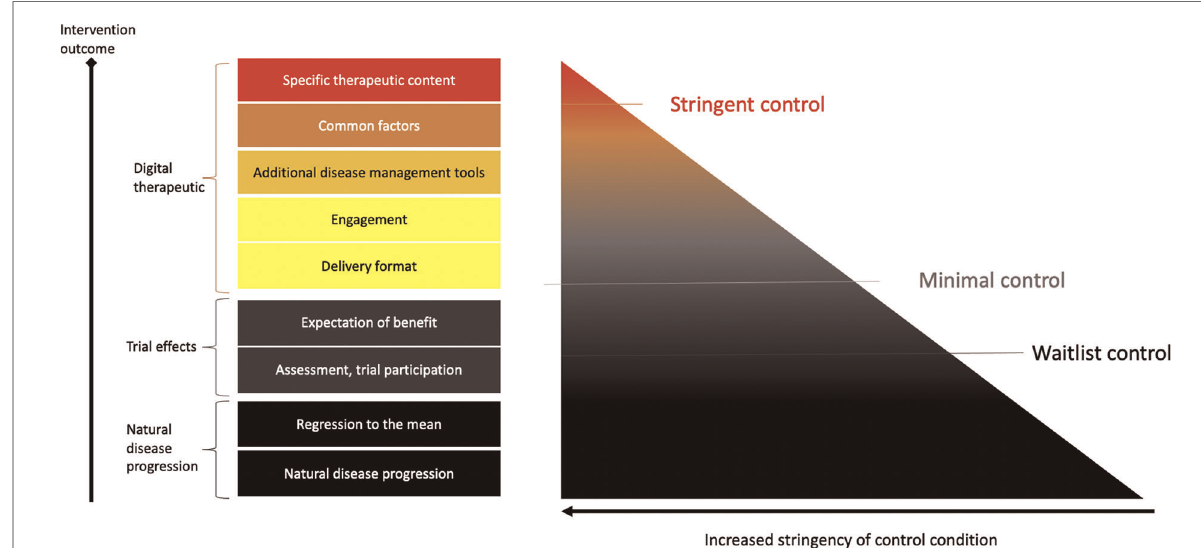
FIGURE 1 Control conditions. Control condition stringency can be distinguished with regards to what aspects are controlled for. For example, waitlist control conditions will control for aspects of natural disease progression and being regularly assessed in a trial. More stringent sham or placebo controls will also contain aspects of a digital control, such as engagement tools, digital disease management tools, such as wellness content or trackers. DTx may also try and establish a working alliance (common factors). Thus, stringent digital sham conditions may not be fully